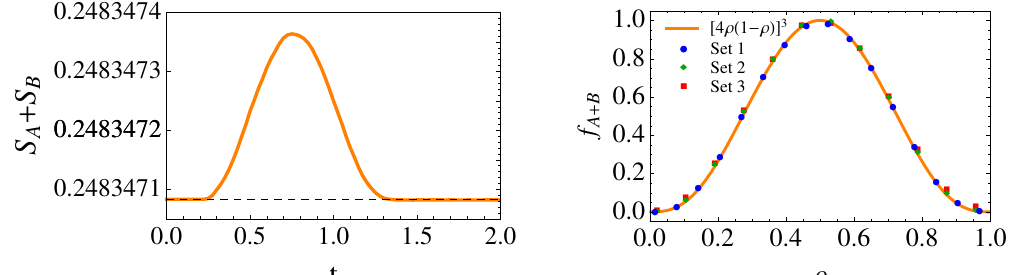
Figure 9 . (Left) Renormalized entanglement entropy S A + S B as a function of time, see (cid:12)gure 4. The (dashed) horizontal line corresponds to the result by using the analytical formulae (3.16) and (3.17). We have set G = 1 and L = 1. (Right) Renormalized entanglement entropy S A + B as a function of time, normalized to [0 ; 1] in both horizontal and vertical axes, see (3.19). The dots correspond to the numerical result with intervals A and B , placed symmetrically with respect to x = 0 as shown in (cid:12)gure 4, in di(cid:11)erent con(cid:12)gurations: Set 1 is ( T L = 0 : 2 ; T R = 0 : 195 ; ‘ A = ‘ B